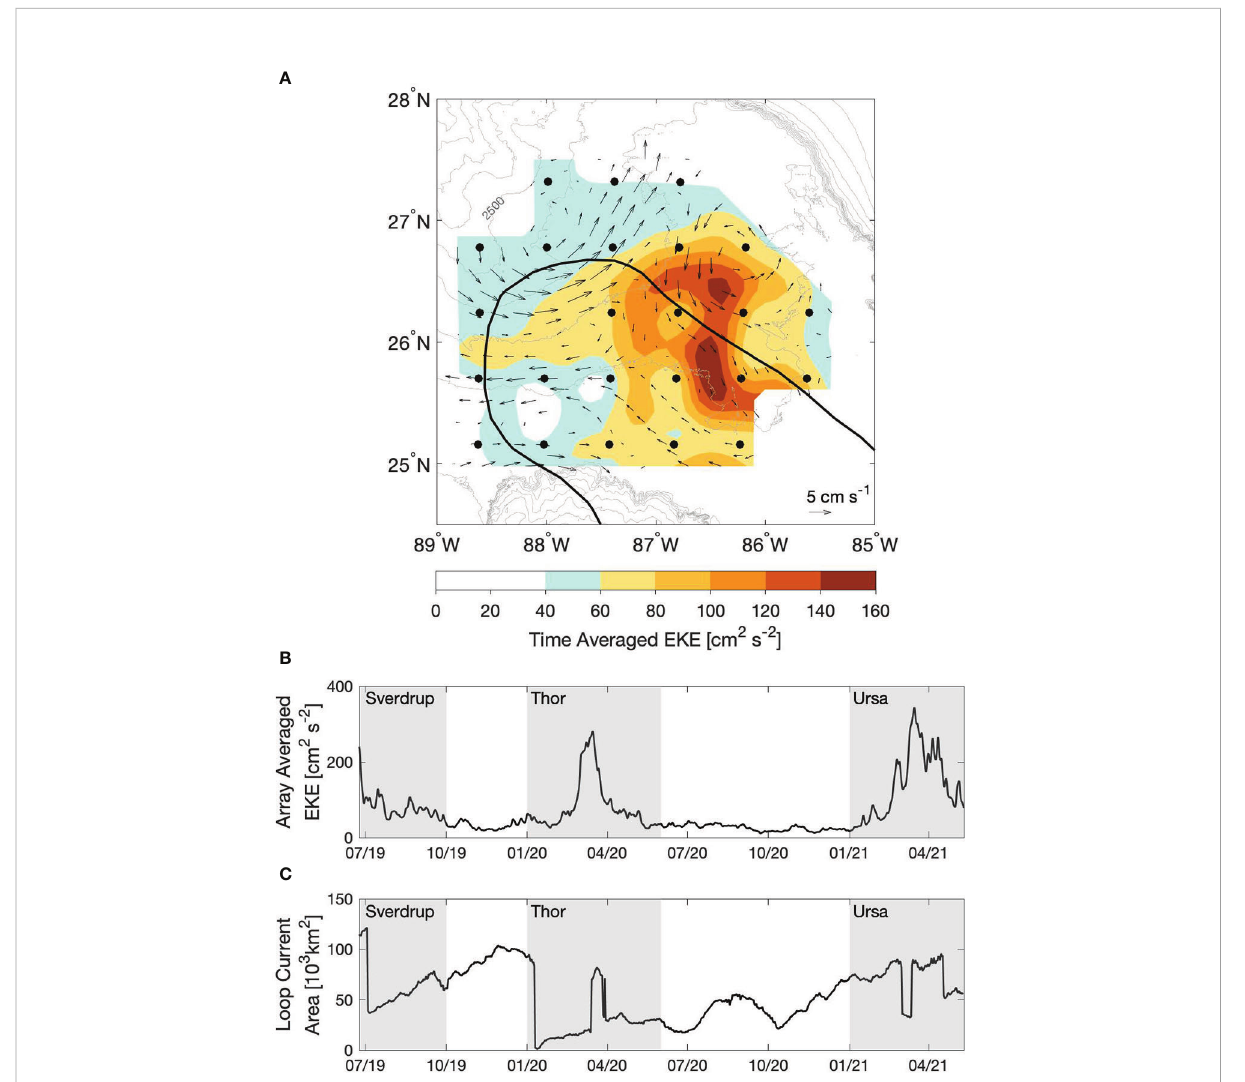
FIGURE 4 Deep eddy kinetic energy and current vectors (A) , time averaged over the study period. The bold SSH contour represents the mean position of the LC. CPIES are denoted by black circles and bathymetry is contoured in gray every 250 meters. The array-averaged eddy kinetic energy (B) is compared against the LC Area (C) , derived from satellite SSH. Formation time-frames for LC Eddies Sverdrup, Thor and Ursa are highlighted by gray